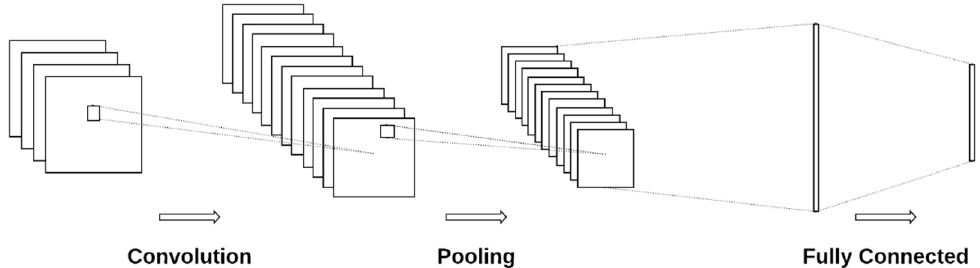
Figure 2. Schematic diagram of a CNN architecture, consisting of convolutional layers, pooling layers, and fully connected layers.